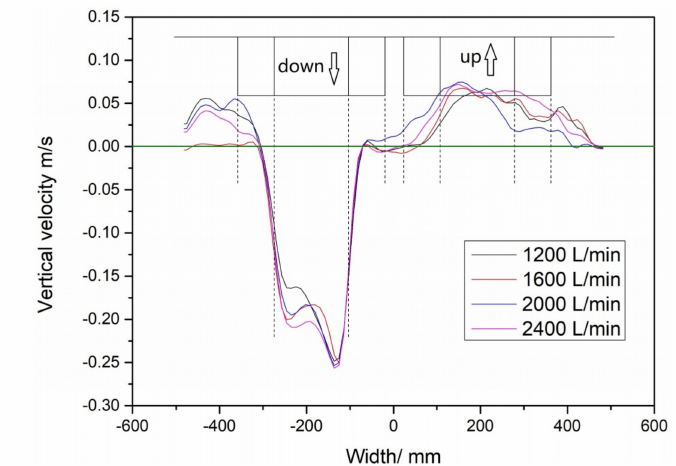
Figure 6. Vertical velocity distribution of flow field in transition layer under di ff erent gas flow rates.